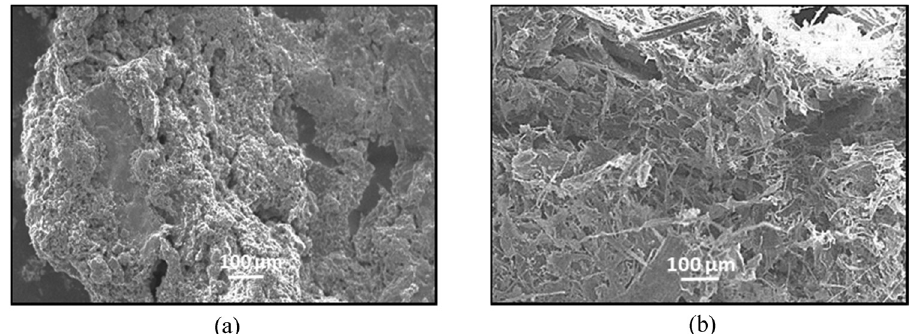
Figure 7: SEM micrograph of ( a ) MCC and ( b ) NCC samples isolated from pineapple